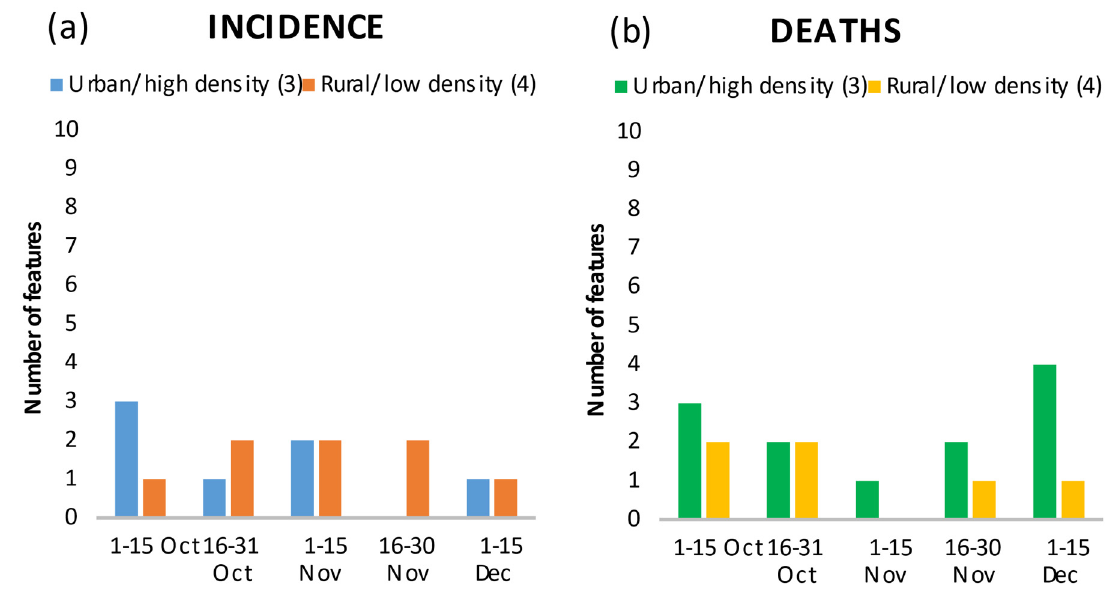
Figure 3. Number of features in the top 20 showing the relationship between migration and geographic dispersion, and incidence ( a ) and death rates ( b ) by time period.